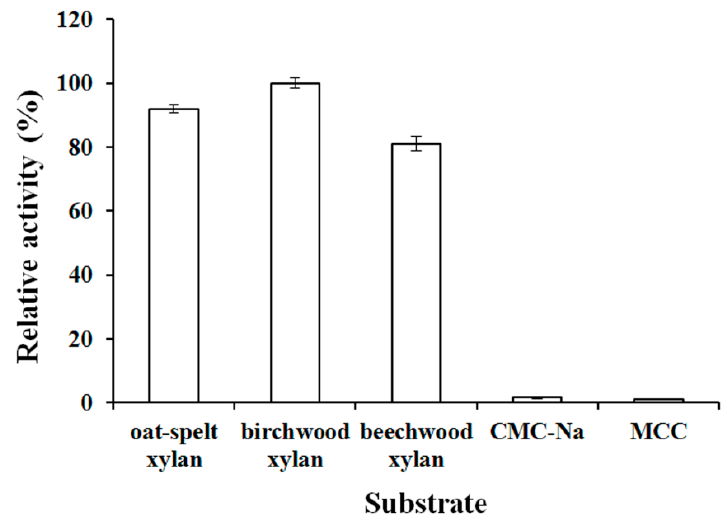
Figure 6. Substrate specificity for the recombinant xylanase. The activity value for birchwood xylan was set as 100 %. CMC-Na: sodium carboxymethylcellulose, MCC: microcrystalline cellulose